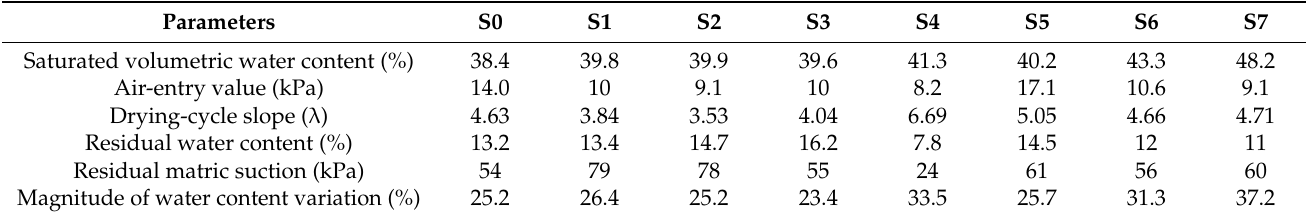
Table 3. Water retention parameters for